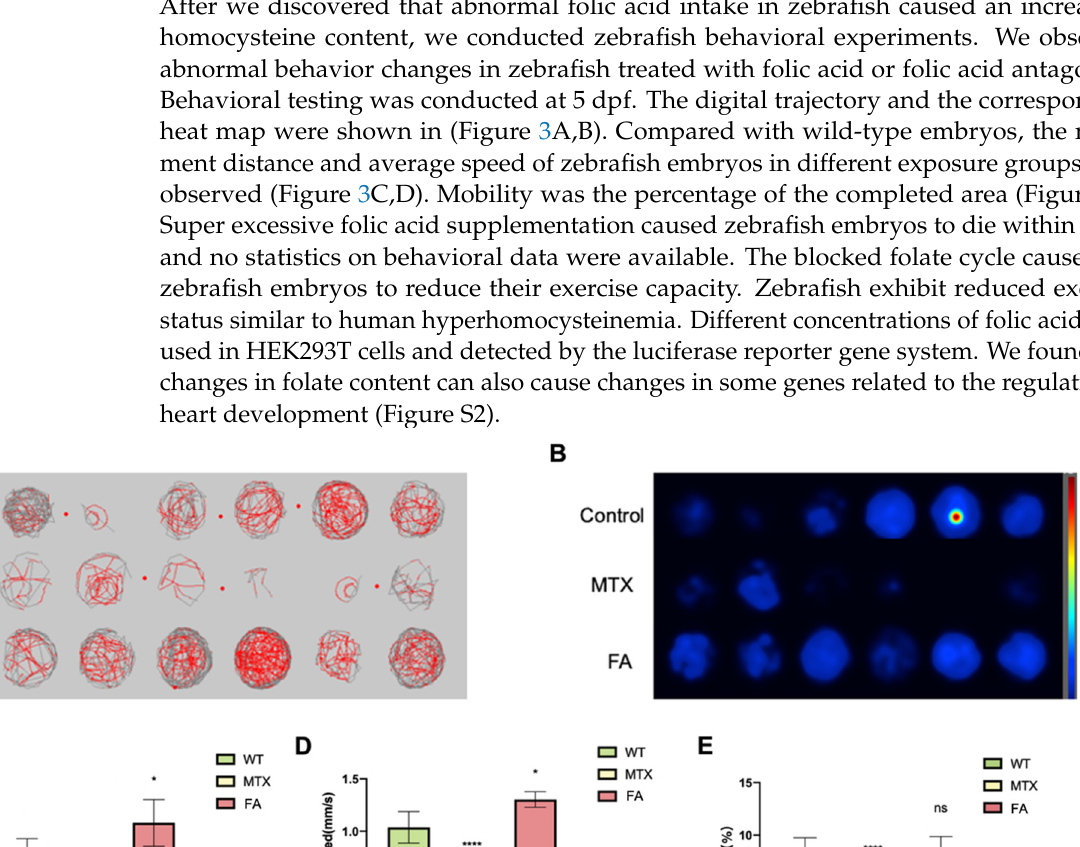
bars: 100 µm. ( B ) Statistics on the influence of different folic acid treatment groups on the looping angle of zebrafish em- bryo heart. ( C ) Statistics on the influence of different folic acid treatment groups on the thickness of the ventricular myo- cardium of zebrafish embryos. ( D ) High homocysteine content in zebrafish of different groups. (Student t -test, * p < 0.05, ** p < 0.01, **** p < 0.0001, ns: no statistical difference).